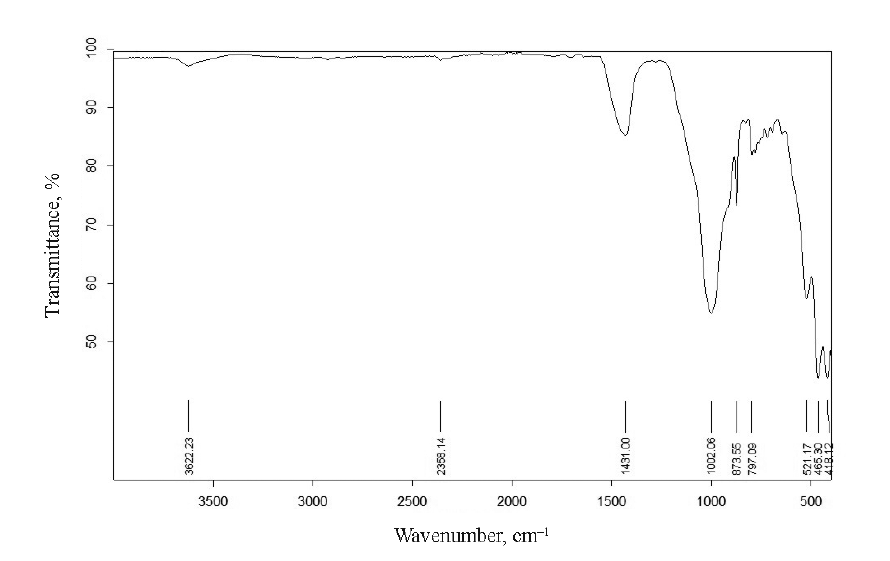
Fig. 4. The FTIR spectrum of Uvurjargalant oil